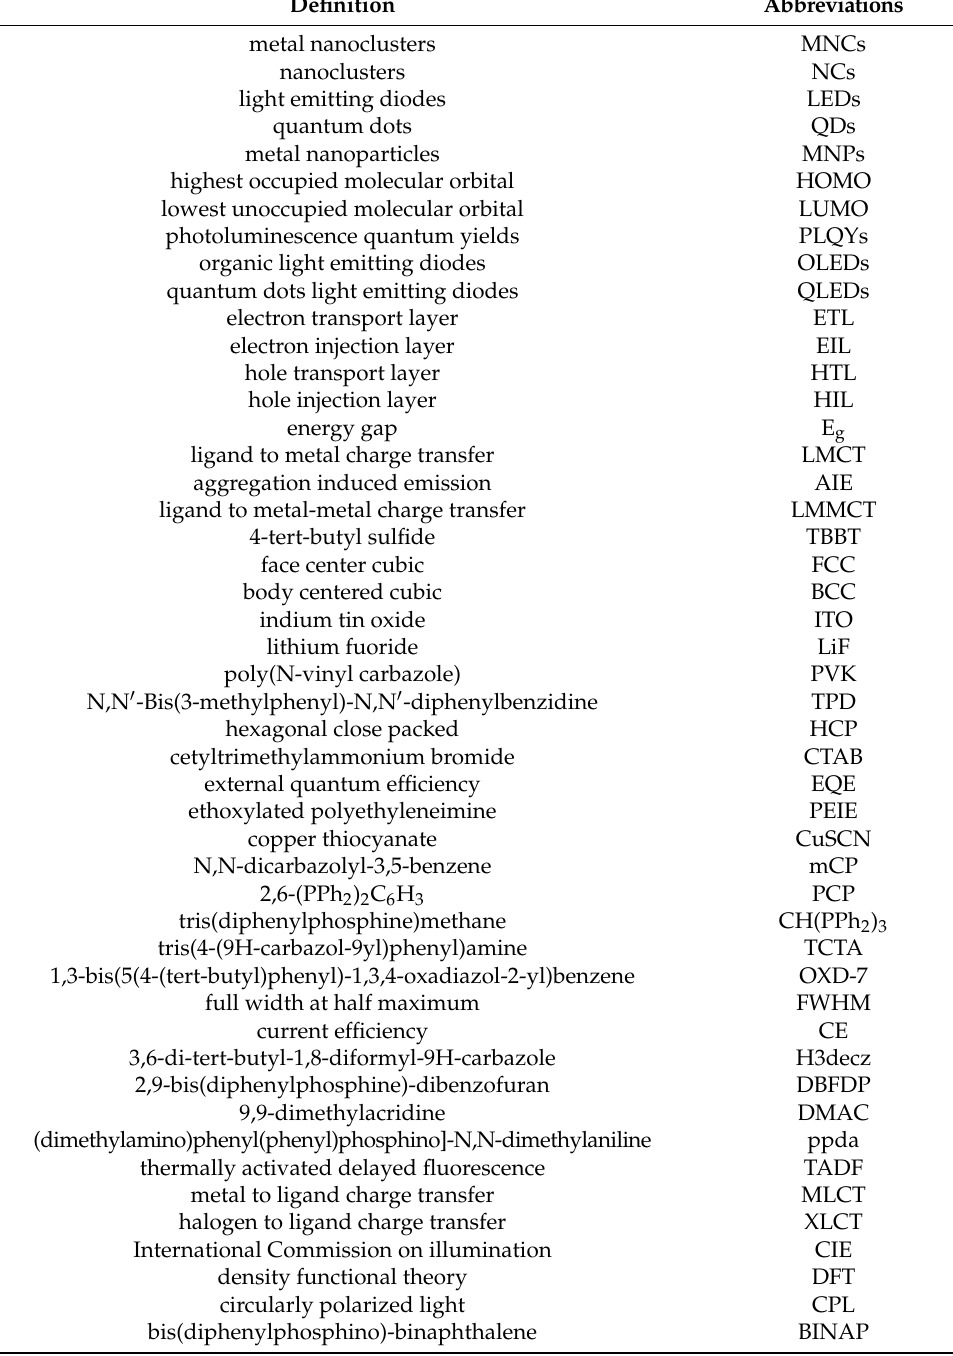
Table 1. The list of all abbreviations used in the